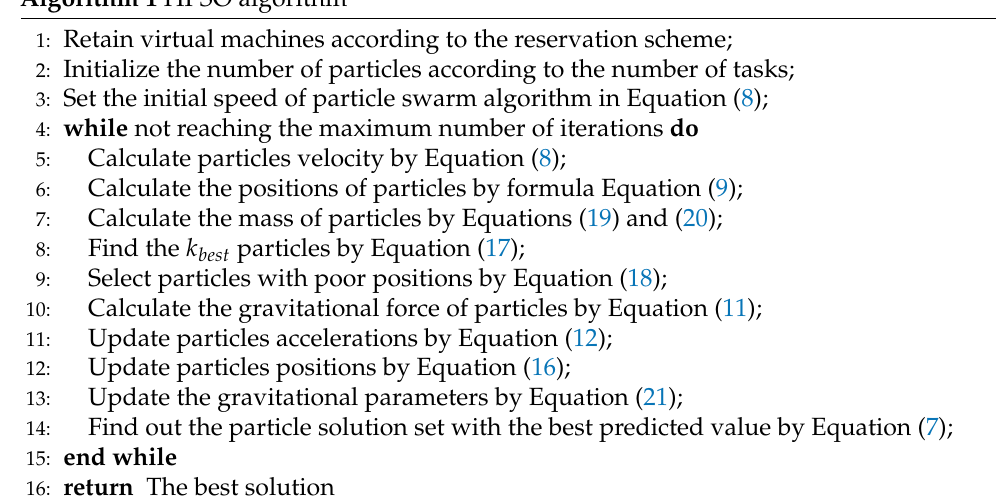
Algorithm 1 HPSO algorithm